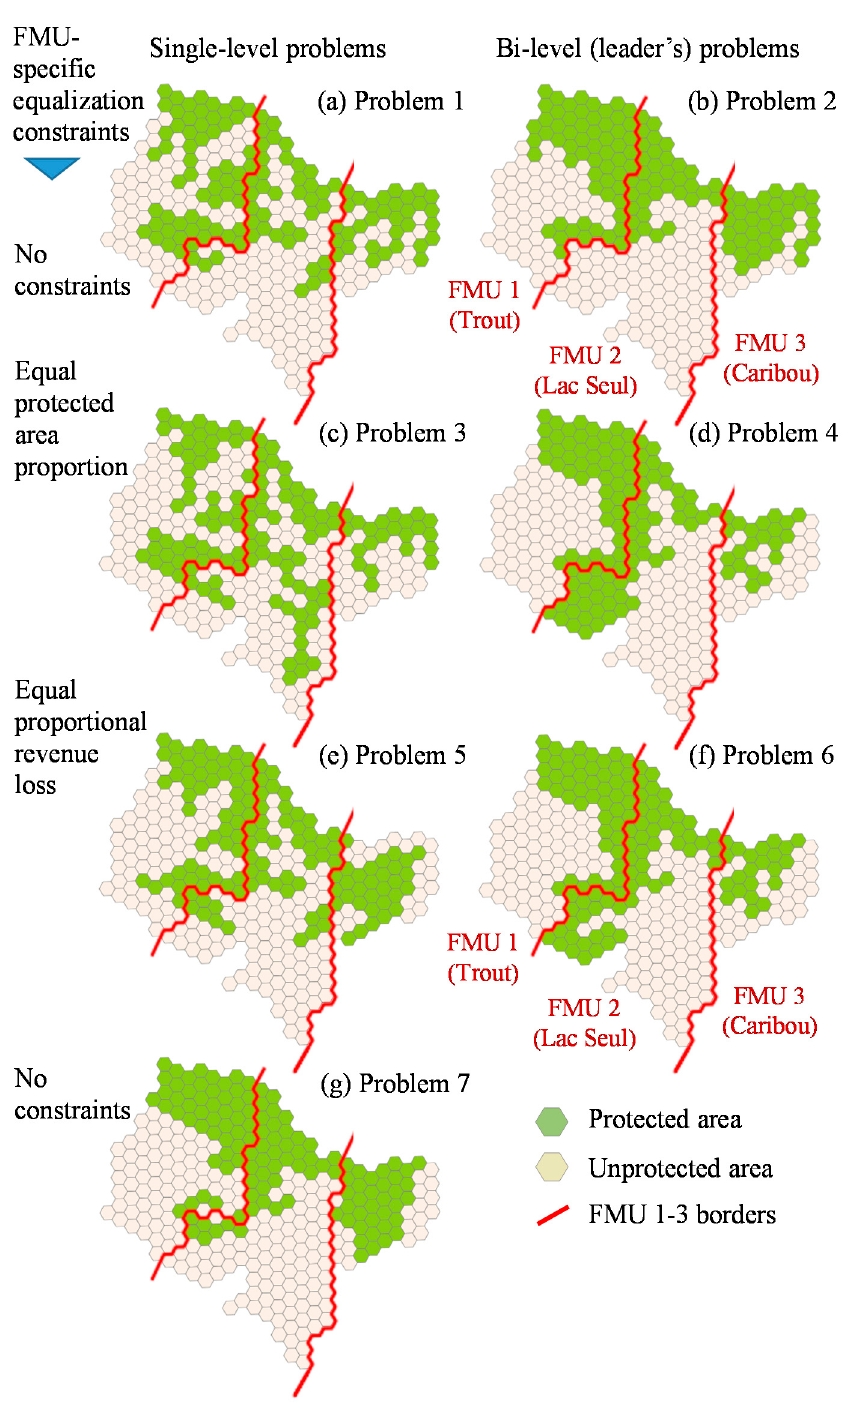
Figure 6. Habitat protection patterns in problem 1–7 solutions, S = 0.4.